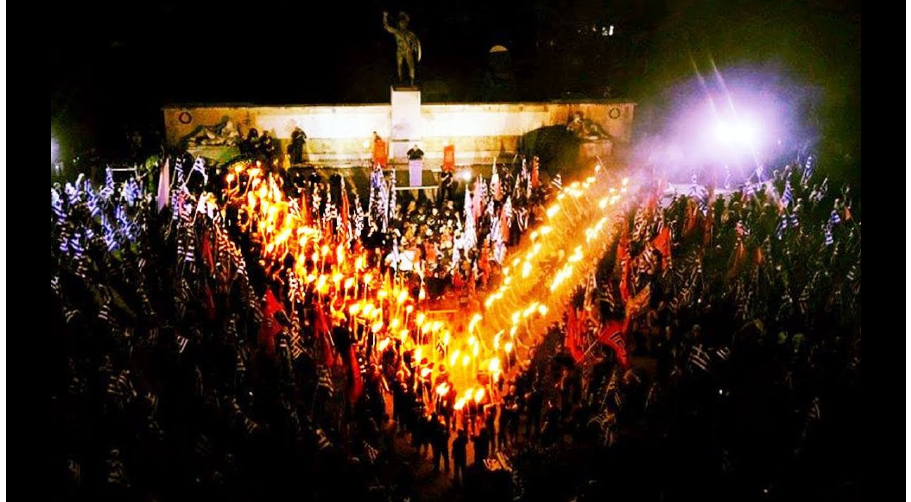
Figure 3. Commemoration event at Thermopylae organised by the Golden Dawn in 2017. [source: screenshot from YouTube video Θερμοπύλες 2017].